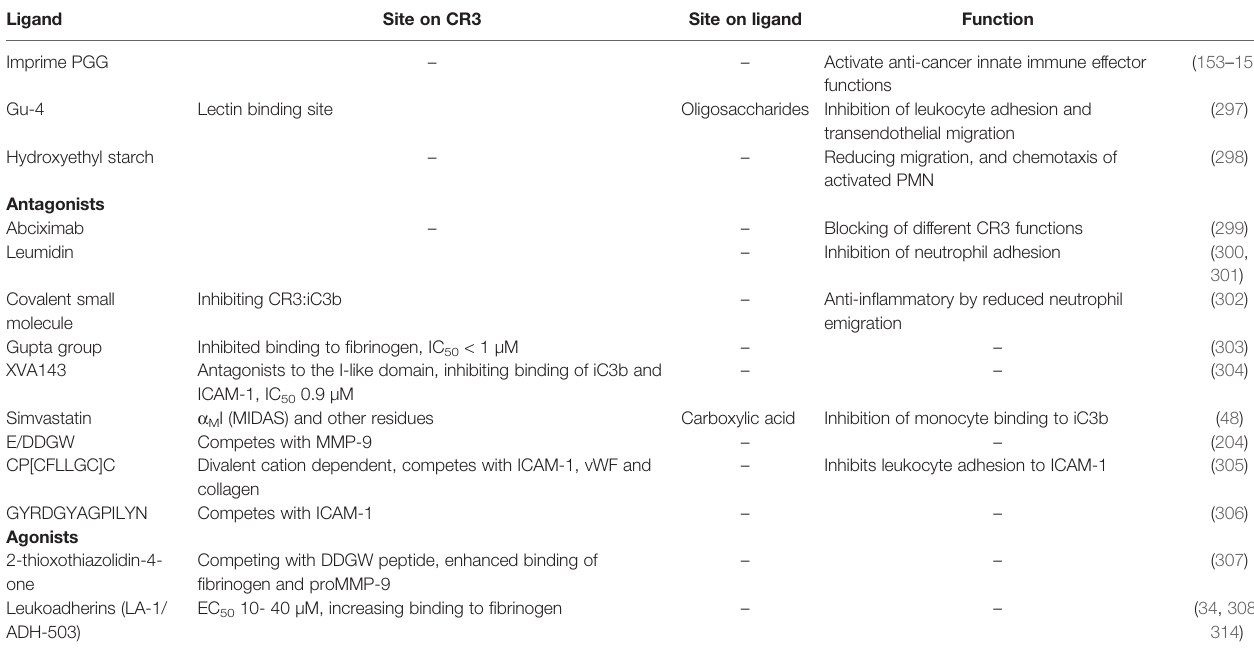
TABLE 9 | CR3 as a potential therapeutic